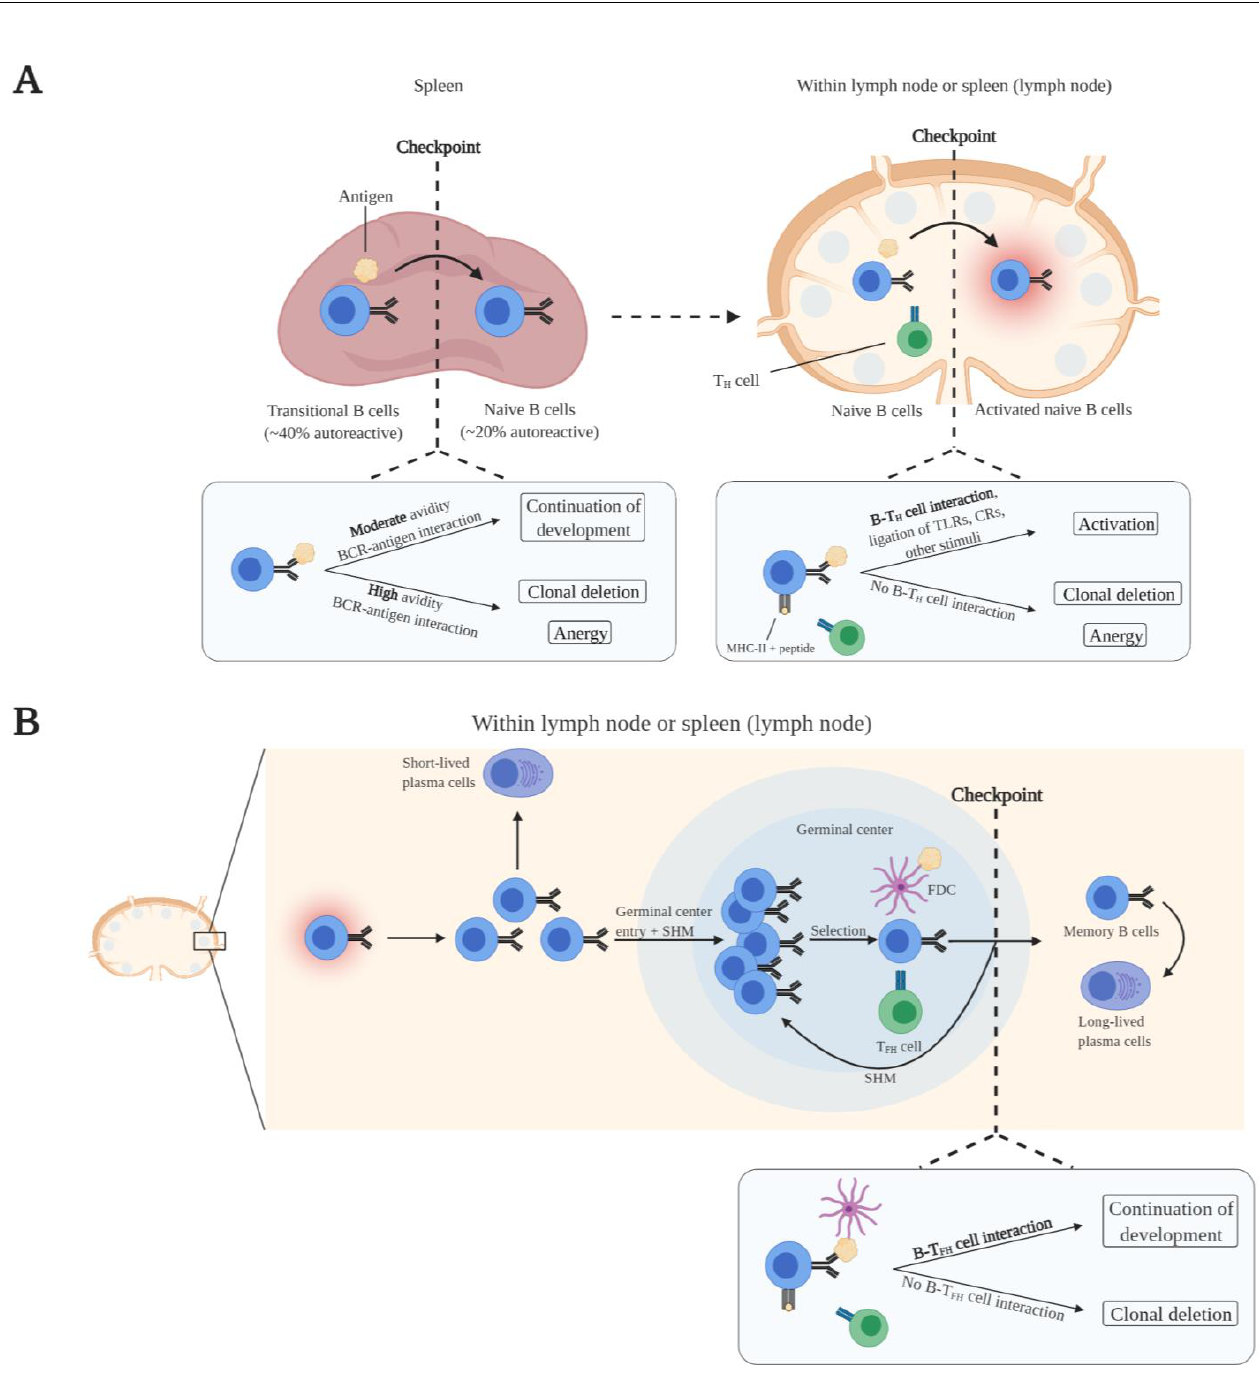
Figure 2. Elimination of autoreactive B cells by peripheral tolerance mechanisms at various checkpoints. ( A ) Maturation of transitional B cells takes place in the spleen. Transitional B cells that strongly bind self-antigens present in the spleen undergo clonal deletion or anergy, which reduces the frequency of autoreactive B cells. The transitional B cells that moderately bind self-antigens mature into naive B cells. Naive B cells predominantly encounter antigens within lymph nodes and the spleen. Activation of naive B cells is dependent on the binding of antigens and interaction with CD4 + T helper (T H ) cells with the same antigen specificity in which B cells receive costimulatory signals. Naive B cells that do not have interaction with T H cells undergo clonal deletion or anergy, which further reduces the frequency of autoreactive B cells. ( B ) Activated B cells enter germinal centers within lymph nodes and the spleen, undergo somatic hypermution (SHM) and isotype switching, and ultimately mature into memory B cells and long-lived plasma cells. These maturation processes are dependent on costimulatory signals from CD4 + follicular T helper (T FH ) cells with the same antigen specificity. Clonal deletion is induced in B cells that do not receive costimulatory signals from T FH cells, resulting in the removal of autoreactive B cells from the B cell pool. Figure was created with BioRender.